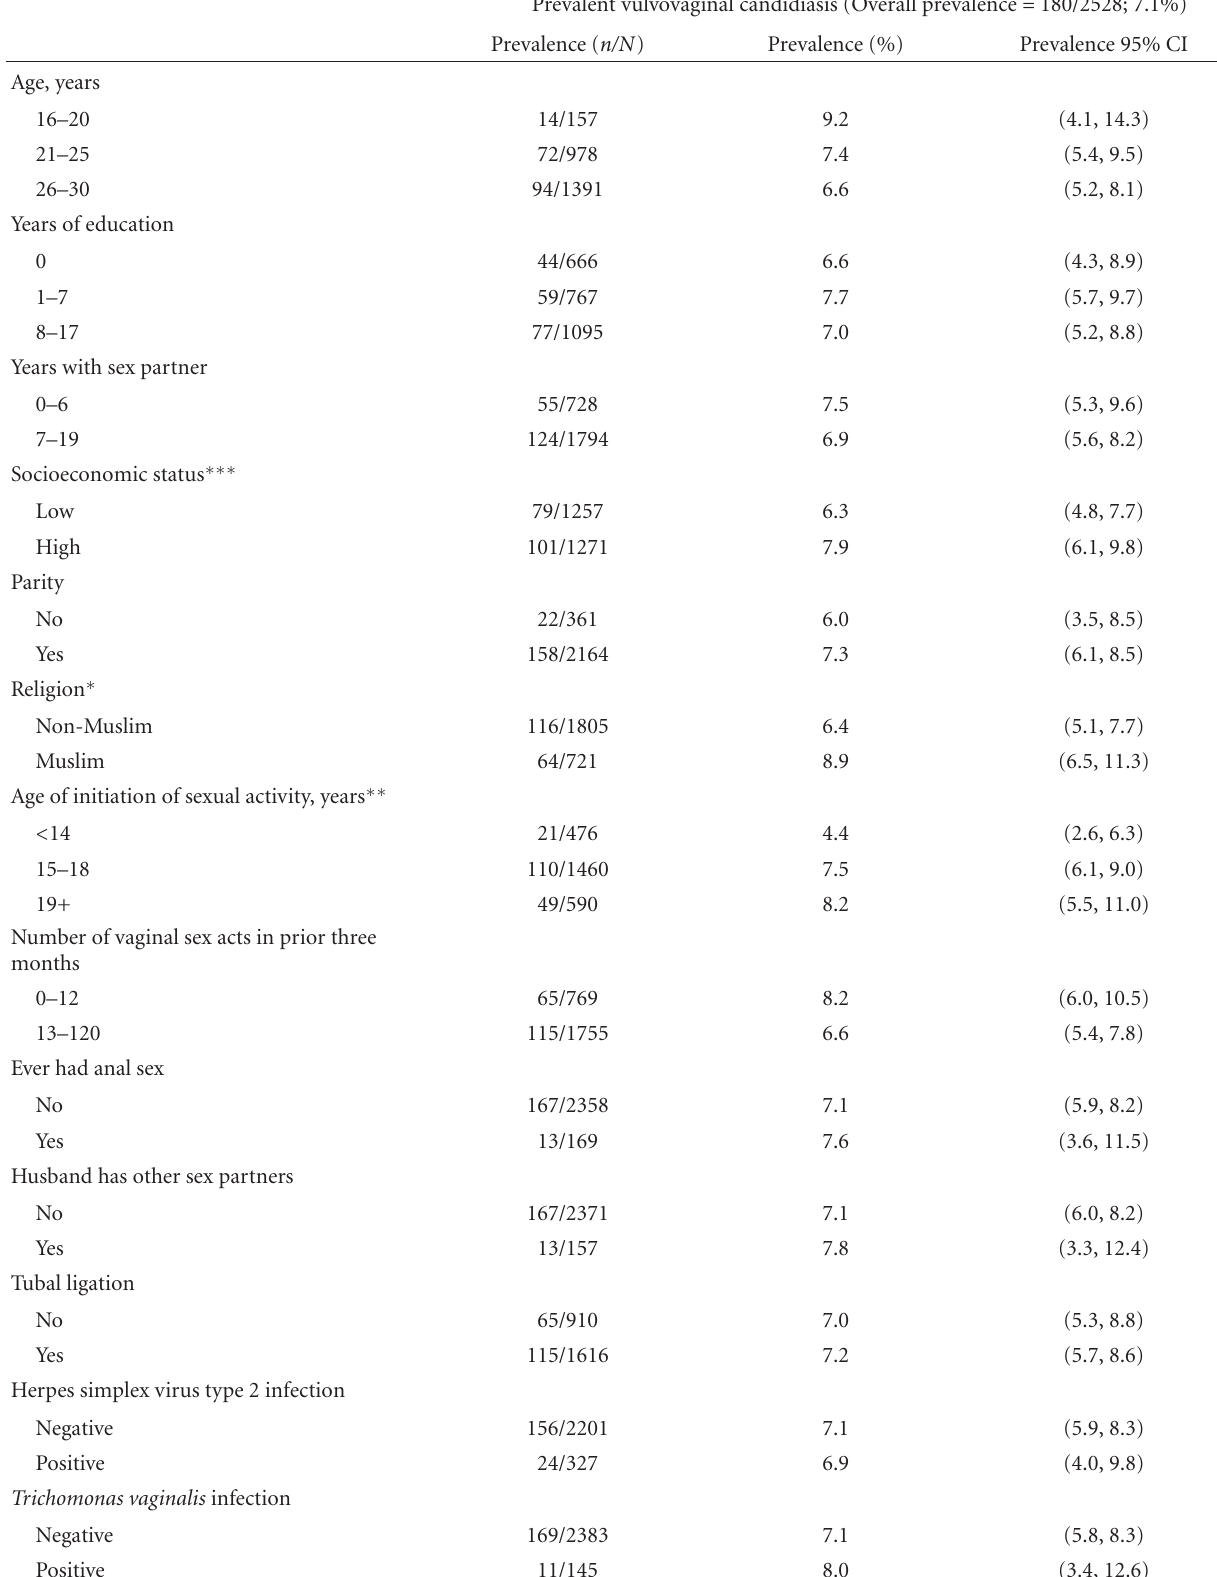
Table 3: Prevalence of vulvovaginal candidiasis by sociodemographic, behavioral, partner, and laboratory measures, Mysore, India 2005-